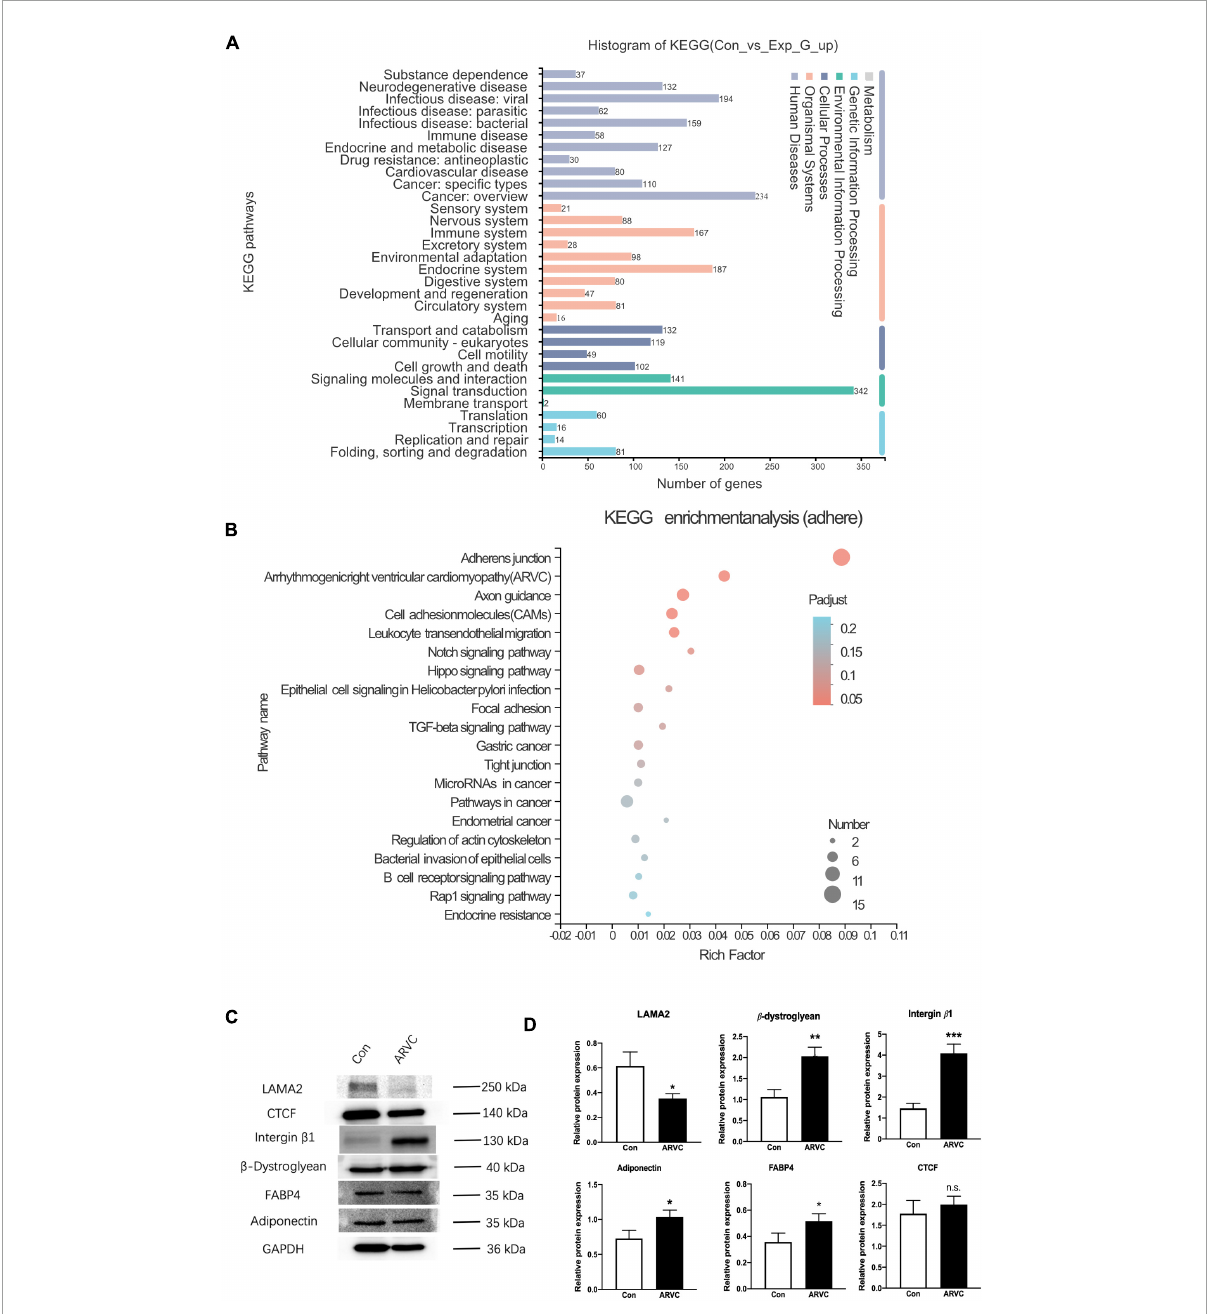
FIGURE5 The analysis of iPSC-derived CMs indicated an ARVC-associated phenotype. (A) Histogram of KEGG signaling pathway classification. (B) KEGG enrichment analysis of the adherent signaling pathway. (C) Western blot results showed the protein expressions of LAMA2, CTCF, Integrin- β 1, β -Dystroglycan, FABP4, and Adiponectin in myocardium cells of the control group and the ARVC group, with GAPDH as internal reference. (D) Histogram shows the protein expression differences of LAMA2, CTCF, Integrin- β 1, β -Dystroglycan, FABP4, and Adiponectin between the control group and the ARVC group (N.S. The difference is meaningless; * p < 0.05; ** p < 0.01; *** p < 0.001).